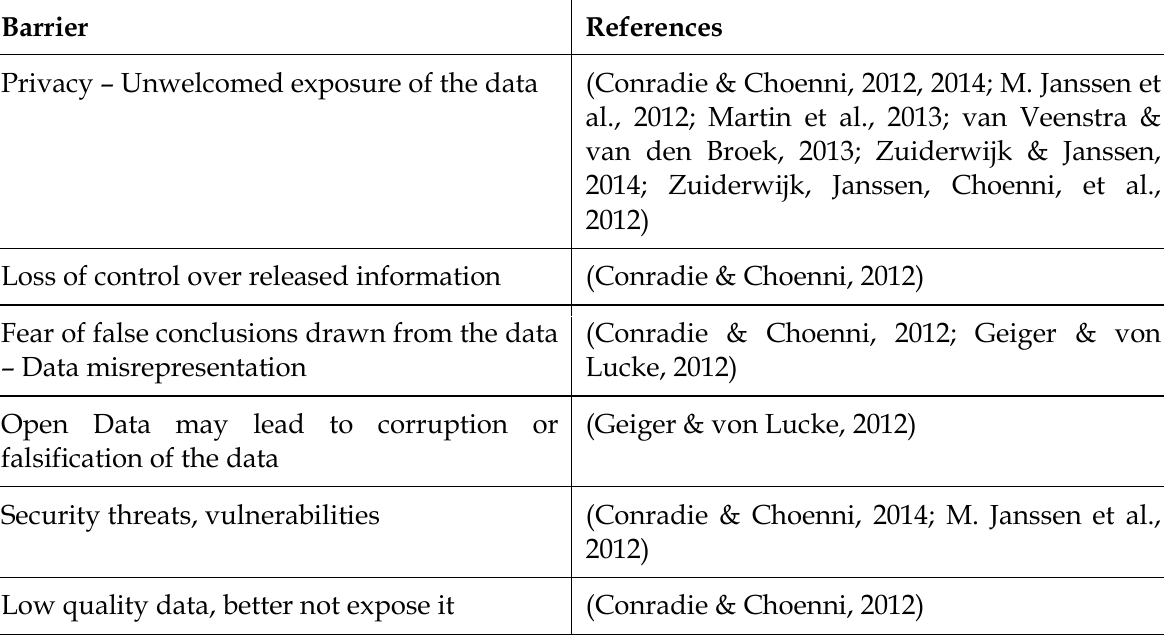
Table 4: Privacy and Security Barriers (Source: Authors)